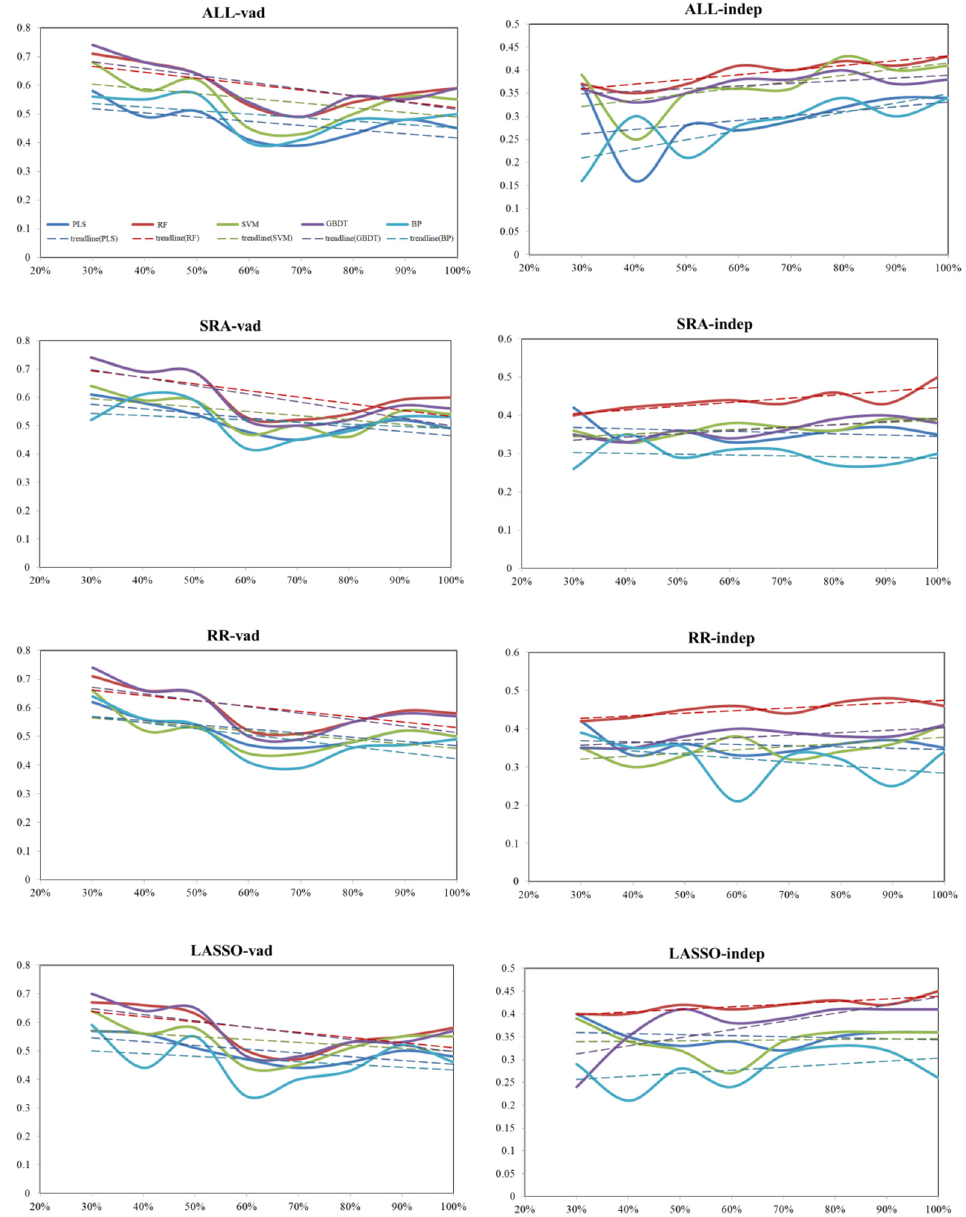
Figure 4. The relationship between changes in the number of samples of each model and R 2 .